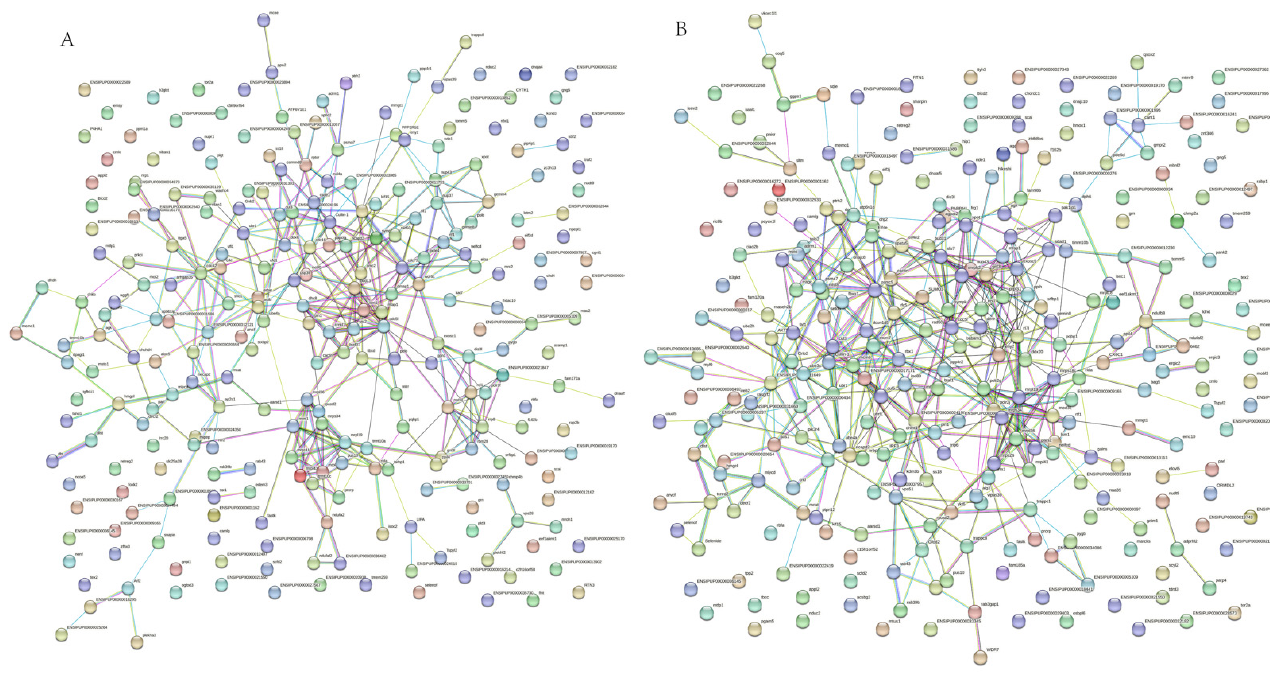
Figure 4. (A) PPI network of differentially expressed proteins (DEPs) from CCO cells with or without SHVV cultured in the complete medium. (B) PPI network of differentially expressed proteins (DEPs) from CCO cells with SHVV cultured in the glutamine-starvation medium or the complete medium. The highlighted nodes were involved in both PPI networks. Table 5. Prediction of proteins associated with SHVV replication.